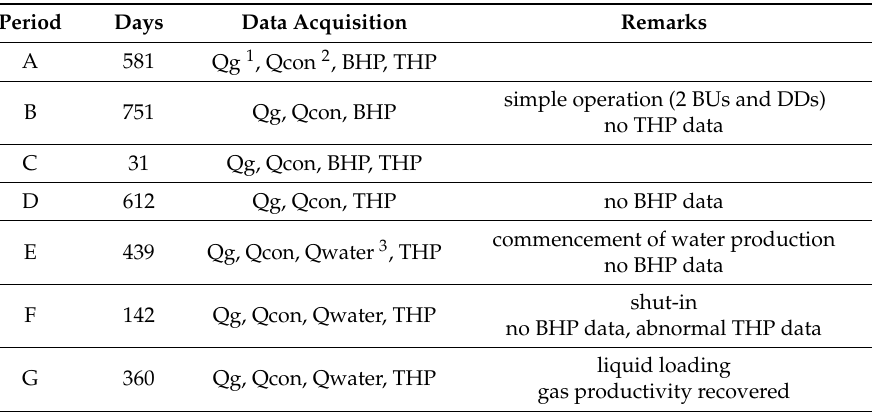
Table 1. Summary of data